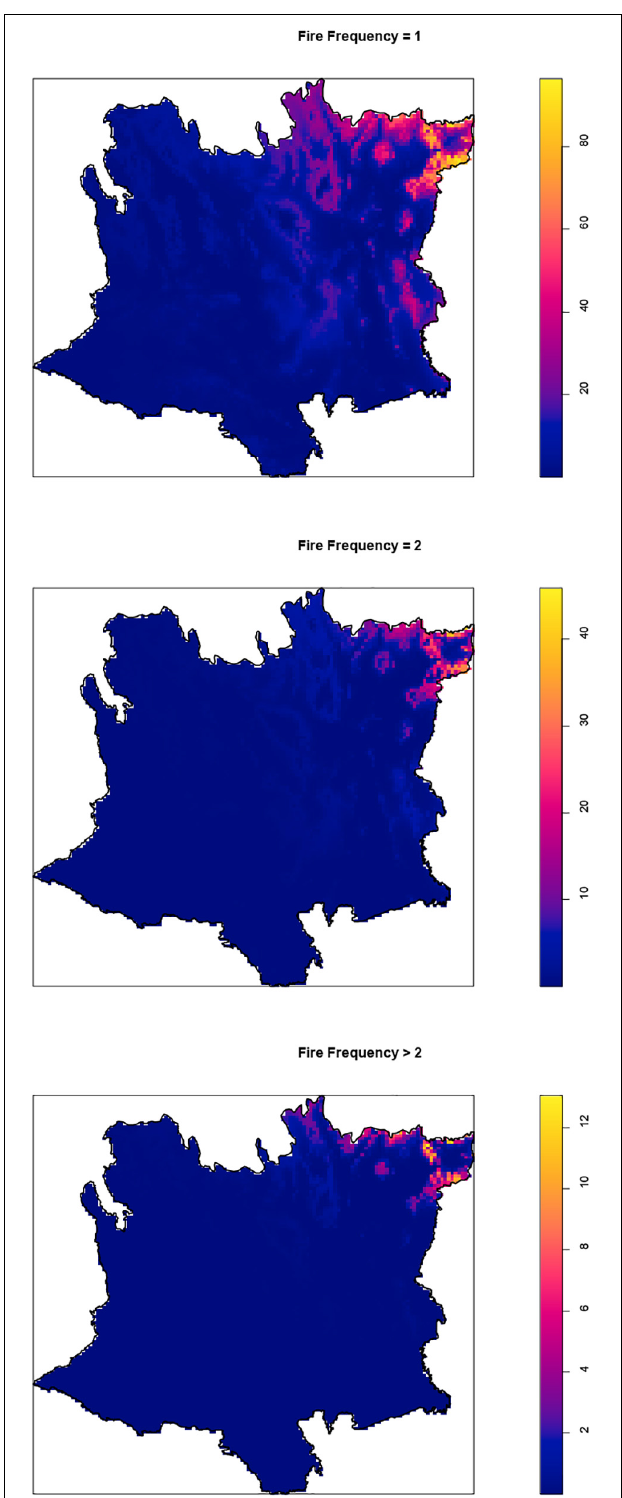
FIGURE 4 | Predicted density of fire occurrence (number of burned pixels 100 km 2 ) in three fire frequency classes (number of times burned from 1972 to 2010) in the Mojave Desert of North America. Density was estimated with a point process model of 250